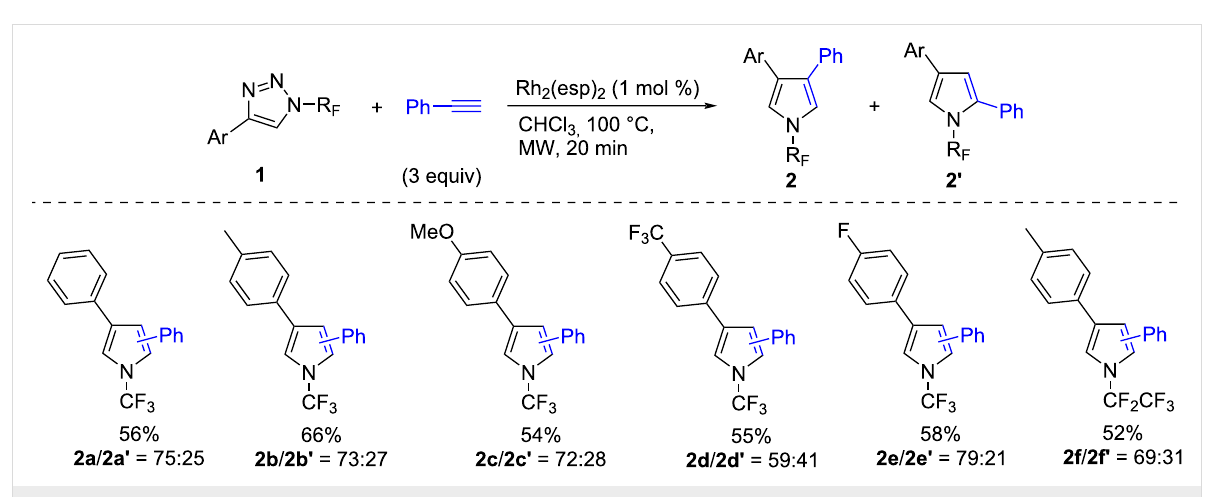
Scheme 2: Transannulation of triazoles 2 with